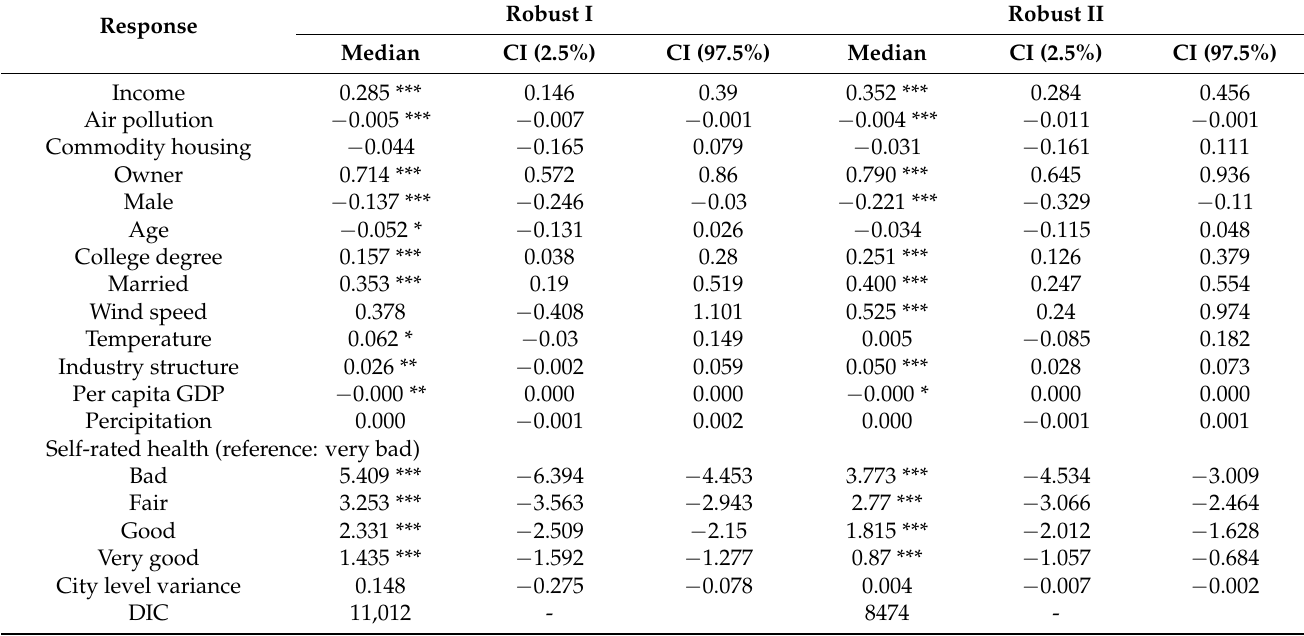
Table 3. Robust check results with different model